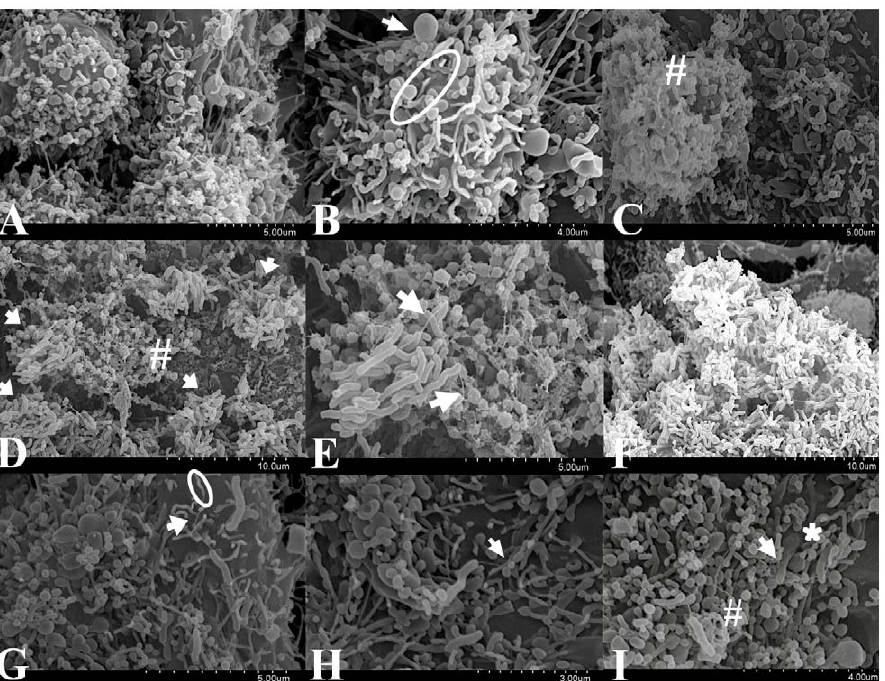
Figure 3. Scanning electron microscopy of human mucin producing intestinal cell line LS174T infected with Campylobacterconcisus strains for six hours. Panel A shows uninfected LS174T monolayers. LS174T cells expressing microvilli (indicated by a ring) and goblet cells (indicated by a arrow) are shown in Panel B. The mucus layer was found on the monolayer surface of LS174T cells as indicated by an ‘‘ # ’’ in Panel C. C. concisus appeared to be attracted to the mucus layer of host cells (indicated by ‘‘ # ’’ in Panel D) using their single polar flagellum (indicated by arrows in Panel E) and upon the interaction with host cells tended to aggregate (Panel F). Panel G shows the polar flagellum (as indicated by an arrow) of C. concisus binding to the tips of host cell microvilli (as indicated by a ring) and goblet cells (as indicated by an arrow in Panel H) which appeared to mediate initial contact with host cells. Following adherence, C. concisus induced a ‘‘membrane ruffling’’-like effect on the host cell membrane (indicated by an asterisk in Panel I) and penetrated the host cell membrane from the non-flagellated end (indicated by an arrow in Panel I) resulting in cell damage (indicated by ‘‘ # ’’ in Panel I).